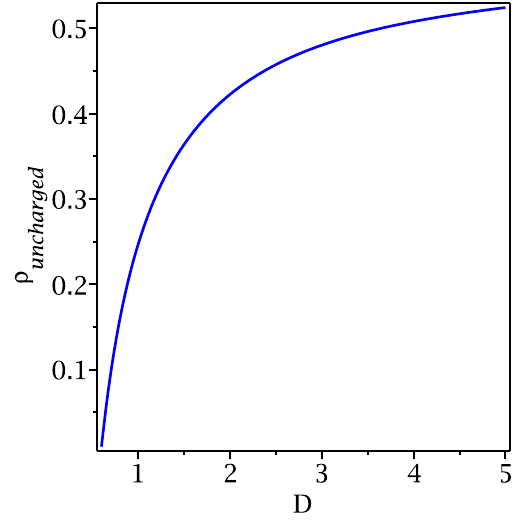
Fig. 10 The line energy density (cid:20) uncharged vs radius D . We have cho- sen m 0 = − 80, H 0 = 70, A = 1, (cid:8)(ε) = − 1, and H (ε) = 1 . 1